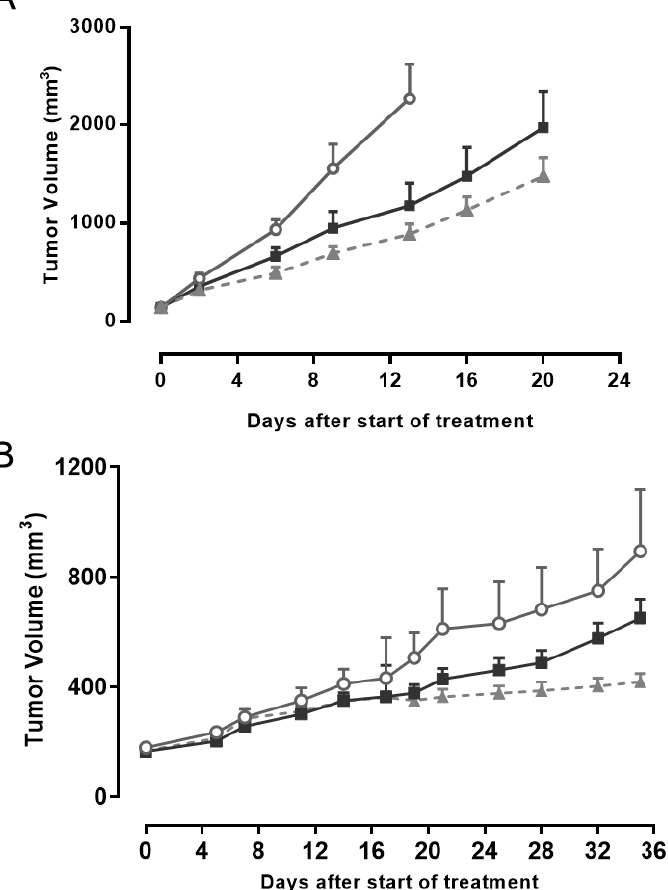
Figure 5. In vivo efficacy of murlentamab. ( A ) Tumor growth inhibition of murlentamab in the hepatocarcinoma PDX model (LI1097). Nude mice (n = 8/group) with established tumors (~145mm 3 ) were treated twice-weekly during 4 weeks by intravenous injection of murlentamab at 20 mg/kg. Sorafenib was administered p.o. at 50 mg/kg every day for 4 weeks. Open circle: vehicle, black square: murlentamab, Grey triangle: Sorafenib. ( B ) In vivo efficacy of murlentamab in the col- orectal cancer PDX model (CTG-0401). Nude mice (n = 12/group) with established tumor (~175mm 3 ) were treated twice- weekly for four weeks by intravenous injection of murlentamab at 20 mg/kg. Irinotecan was injected i.p. at 100 mg/kg at day 1, 7 and 14. Open circle: vehicle, black square: murlentamab, Grey triangle: